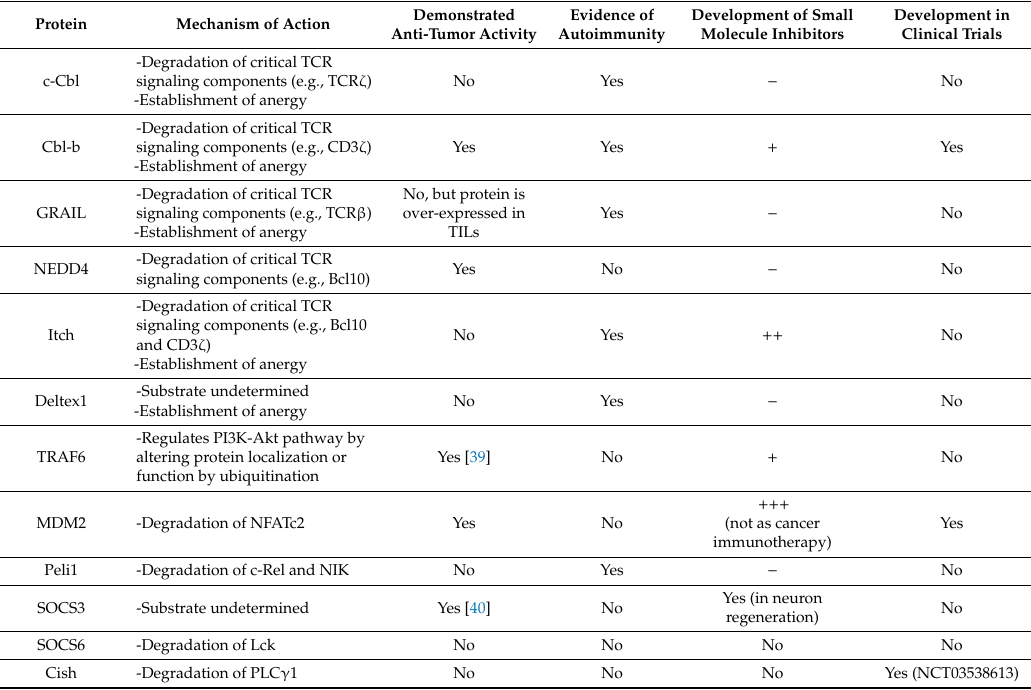
Table 1. E3 ubiquitin ligase intracellular